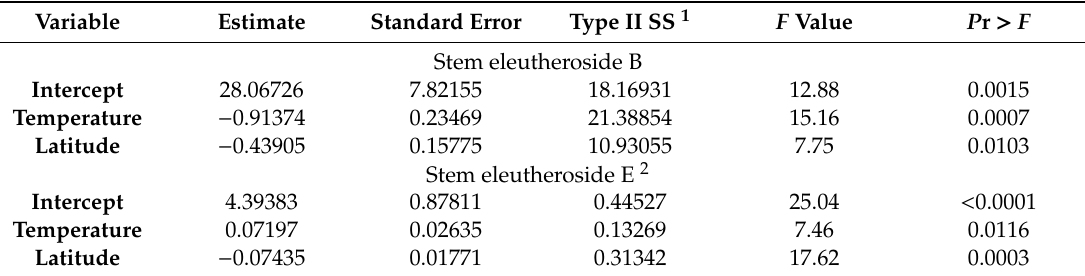
Table 4. Stepwise regression of temperature and latitude factors on eleutheroside B and E concentrations in Eleutherococcus senticosus stems.